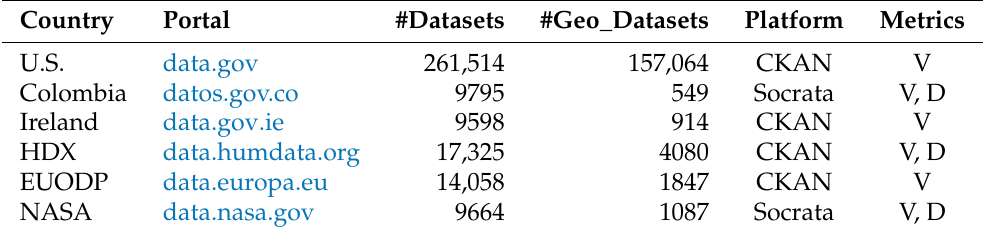
Table 1. The demographic characteristics of the national and international OGD portals. The software platform adopted and the usage metrics available V (View), D (Downloads) are reported. Country Portal #Datasets #Geo_Datasets Platform Metrics U.S. data.gov 261,514 157,064 CKAN V Colombia datos.gov.co 9795 549 Socrata V, D Ireland data.gov.ie 9598 914 CKAN V HDX data.humdata.org 17,325 4080 CKAN V, D EUODP data.europa.eu 14,058 1847 CKAN V NASA data.nasa.gov 9664 1087 Socrata V,